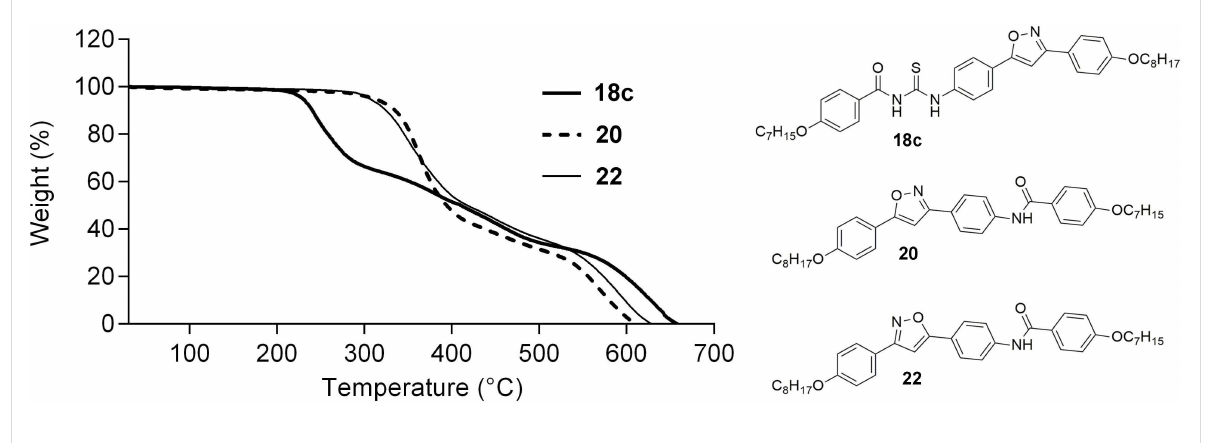
Figure 4: TGA analysis for thiourea 18c ; and amides 20 and 22